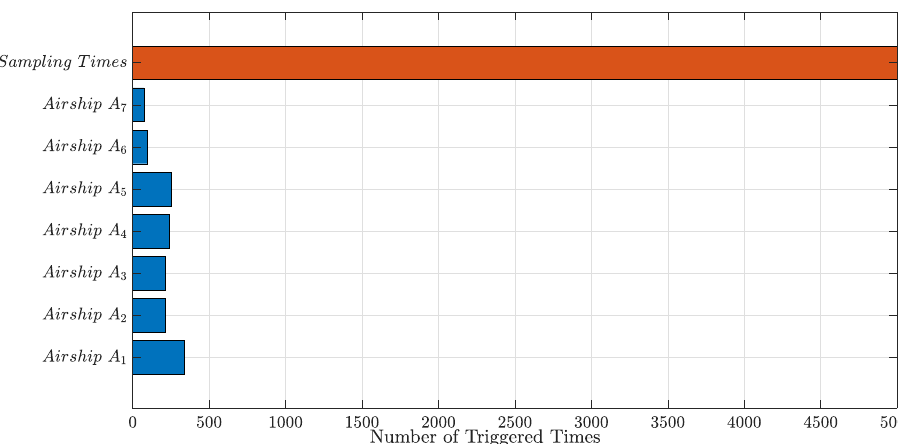
Figure 11. Triggered times constrast between the event-triggered mechanism and the time-triggered